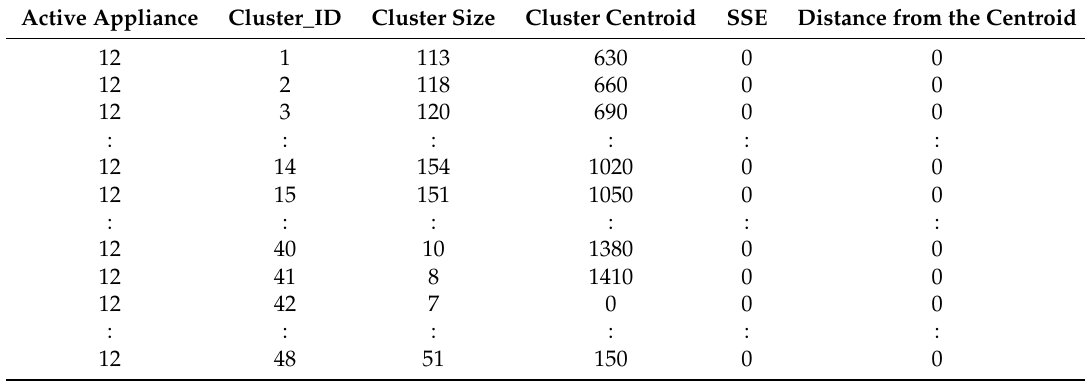
Table 5. Cluster analysis: discovered clusters database.